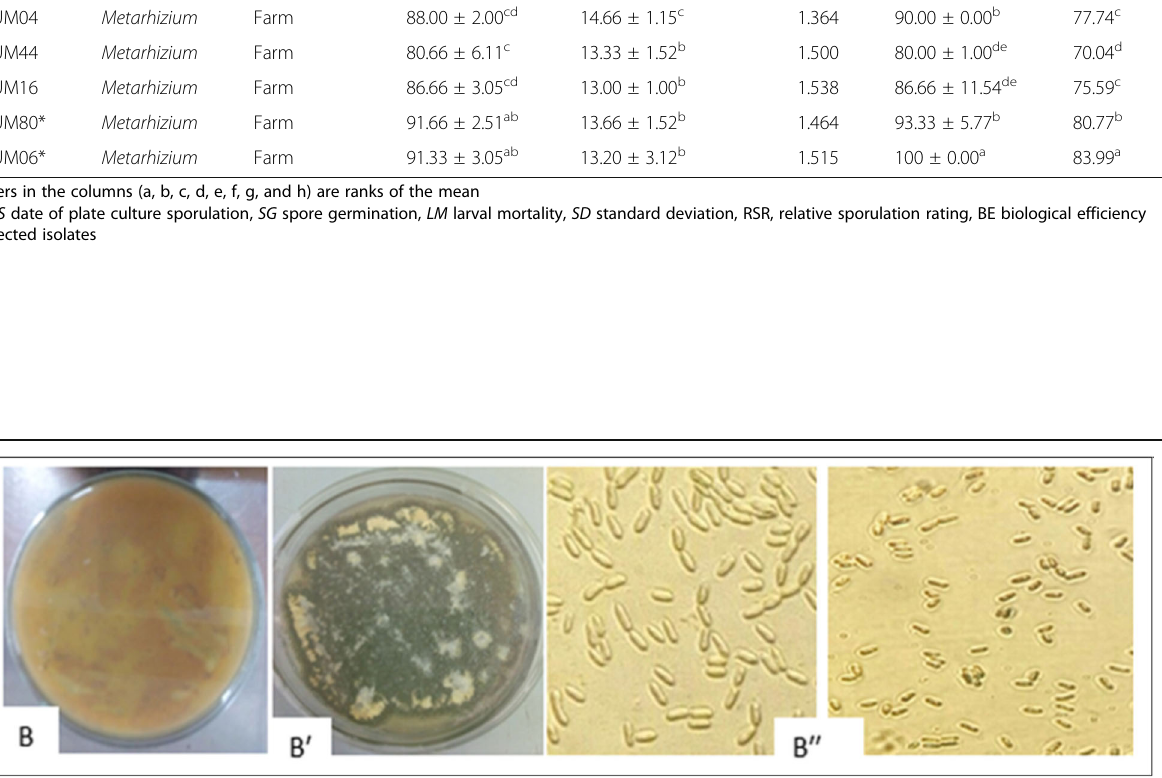
Fig. 1 Reverse ( B ) and front ( B ′ ) view of plate culture and spore structures ( B ′′ ) of Metarhizium